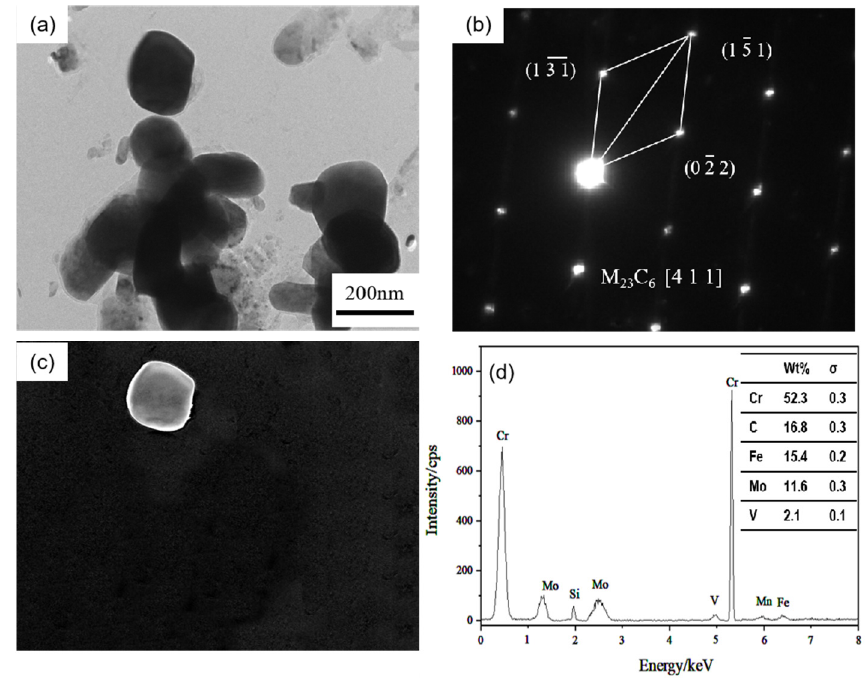
Figure 8. TEM of M 23 C 6 carbide in 0.3 Si steel after tempering for 64 h at 650 °C: ( a ) bright field image of carbide; ( b ) SAED pattern; ( c ) corresponding dark field image; ( d ) EDS analysis.